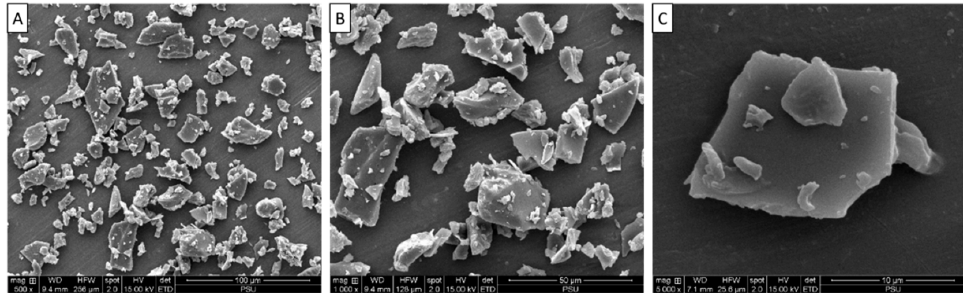
Figure 3. Scanning electron microscopic images of freeze-dried crude tuna pepsin powder contain- ing 10% maltodextrin and 5% trehalose (magnification at ×500 ( A ), ×1000 ( B ), and ×5000 ( C )).